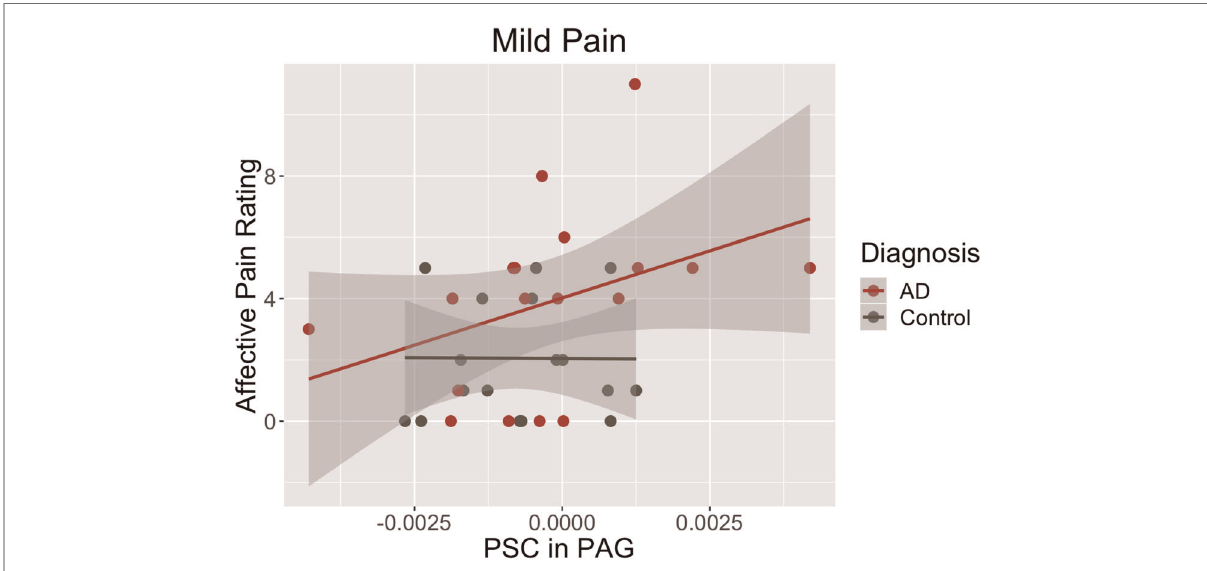
FIGURE 2 During mild pain, the correlation of PAG percent signal change with affective ratings was statistically signi fi cant in the complete sample ( r s =0.34, p = 0.042). That effect was driven by a strong correlation within the Alzheimer ’ s group ( r s =0.54, p